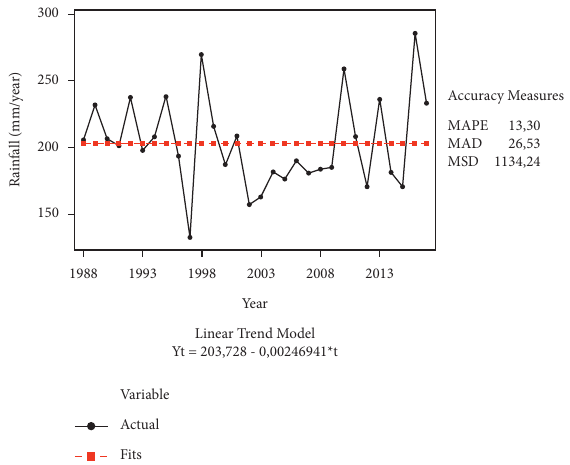
Figure 4: Rainfall trend (mm/year) at research locations over the last 30 years